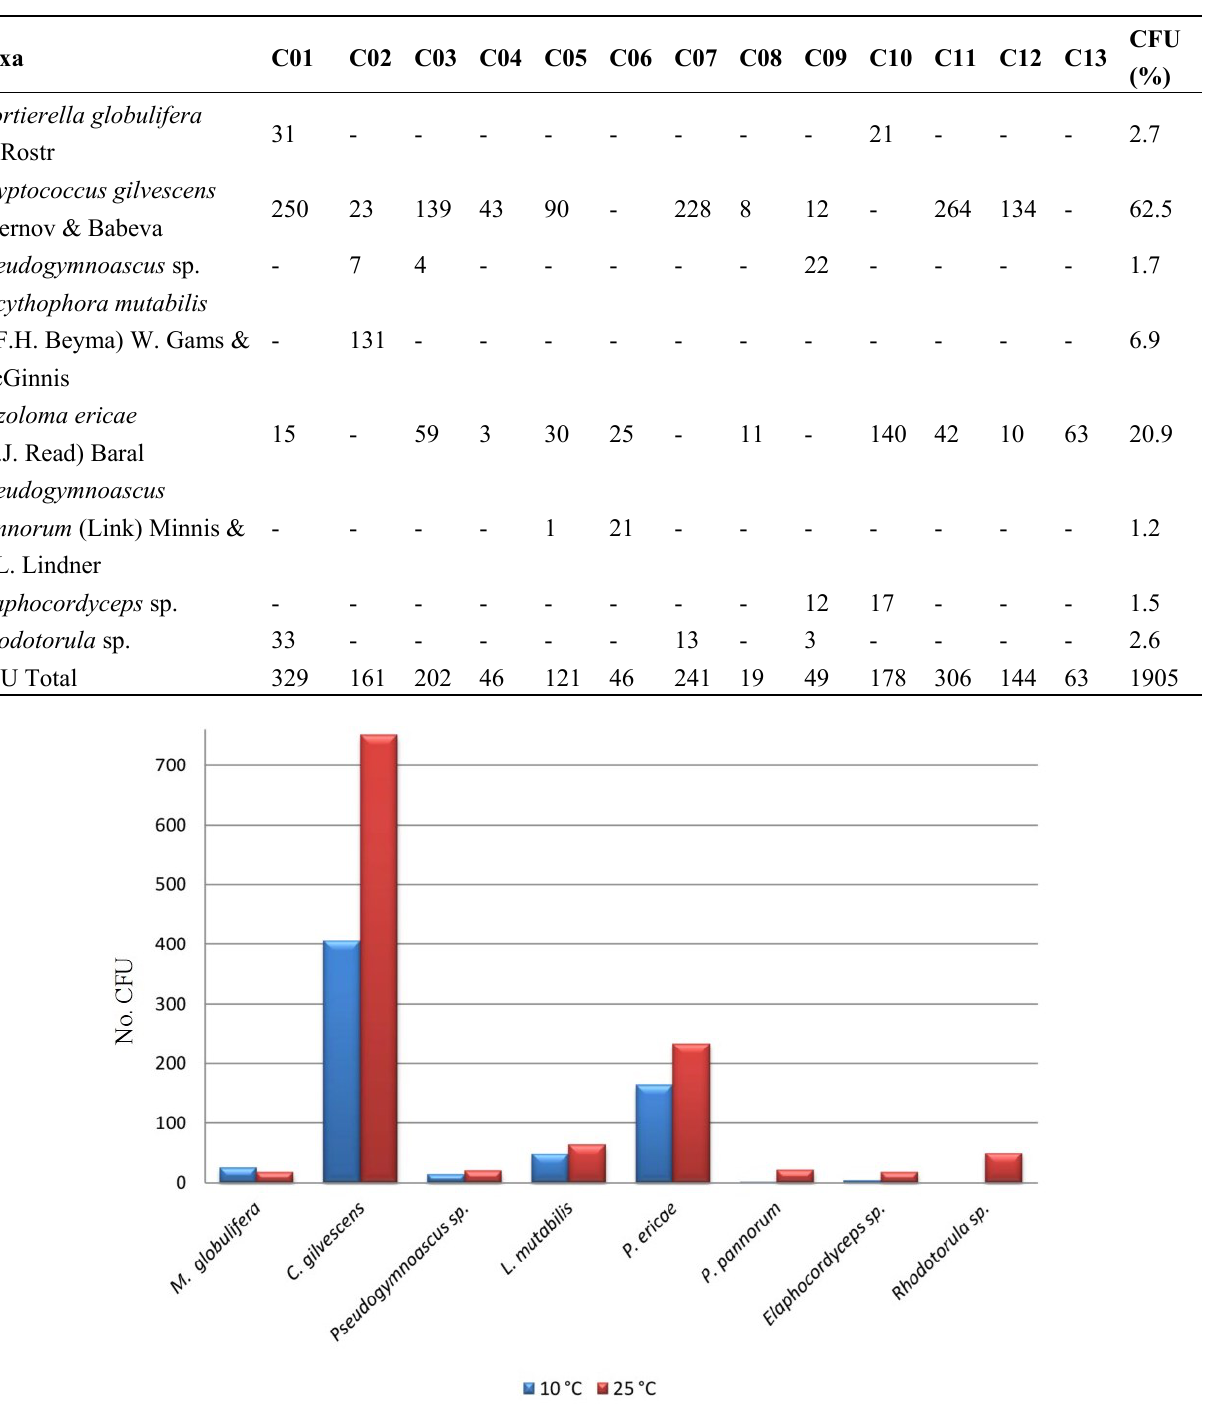
Figure 3. Abundance (number of CFU) of the isolated fungal strains after the 21st day at both isolation